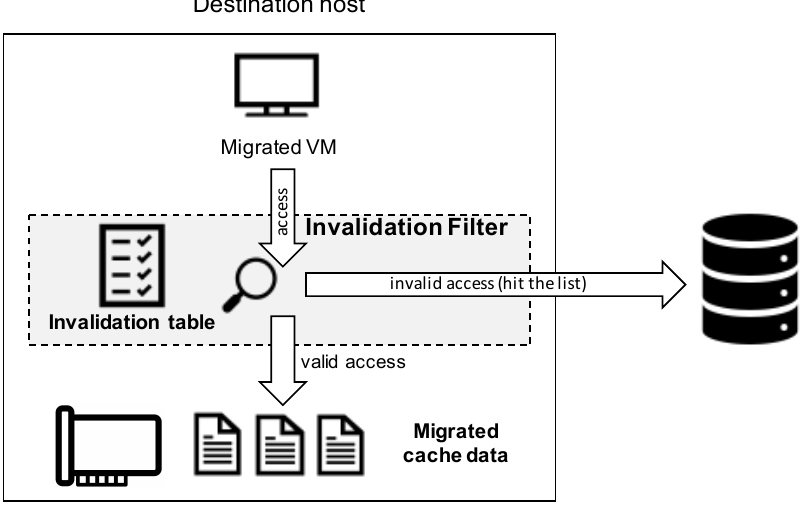
Figure 4. Invalidation procedure by